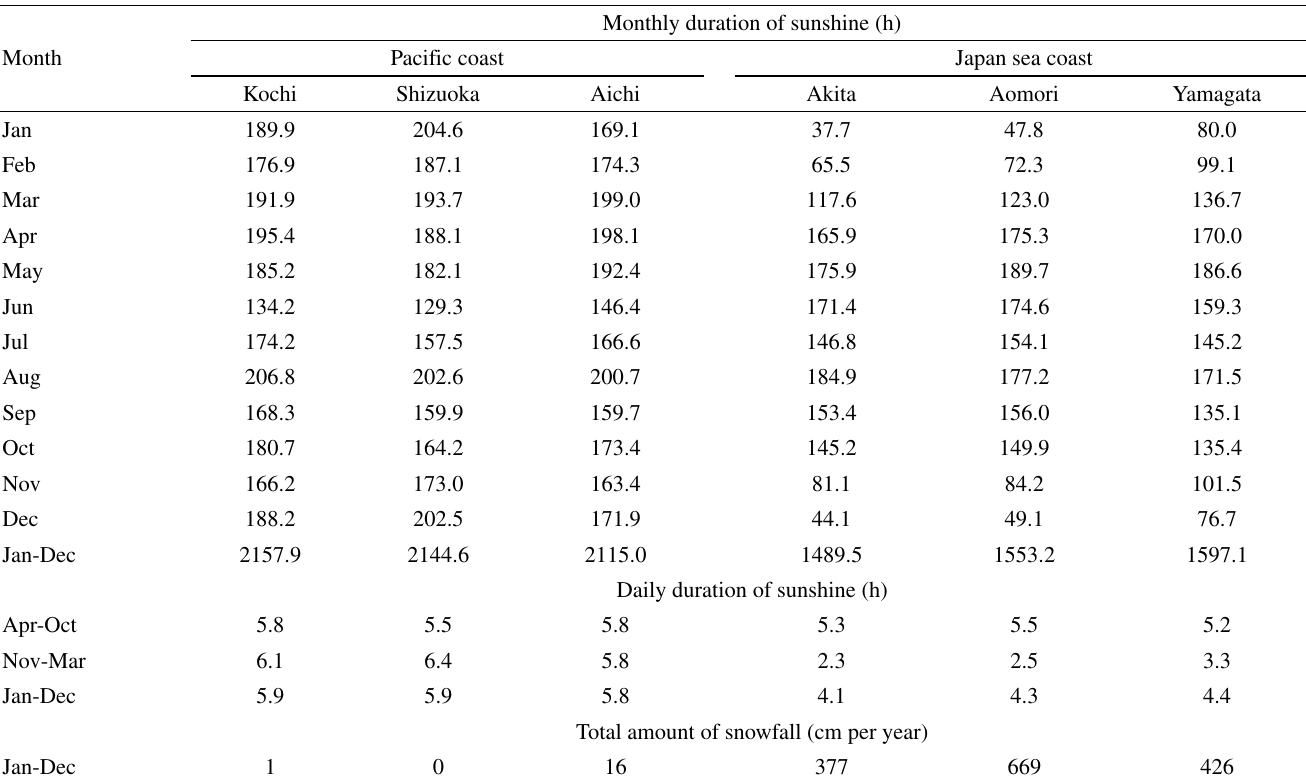
Table created from the database of the Japan Meteorological Agency in